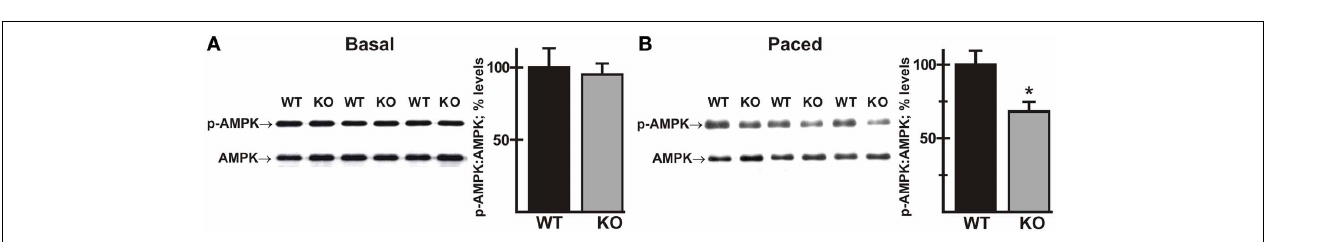
FIGURE 9 | Phosphorylation of AMPK in wild-type and AE3-null hearts subjected to atrial pacing in vivo . WT and AE3-null (KO) mice were anesthetized, instrumented, and subjected to pacing as described in Figure 2 . Ventricular tissue was harvested under basal conditions in instrumented controls or during pacing at 550bpm. Immunoblot and densitometric analyses of homogenates were carried out to determine